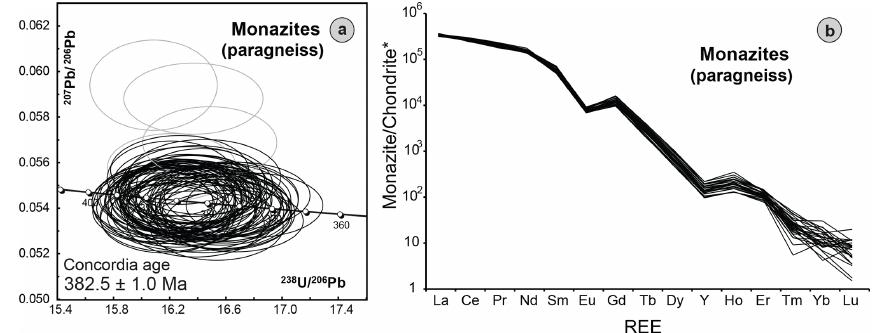
Figure 8. (a) Tera–Wasserburg diagram showing distribution of analyzed monazite ( n = 76) from Sobrado paragneiss (JBP-71-15). The rejected analyses are represented by gray ellipses. The ellipses represent the 207 Pb / 206 Pb and 238 U / 206 Pb errors ( ± 2 σ ). (b) Chondrite- normalized REE patterns for the same